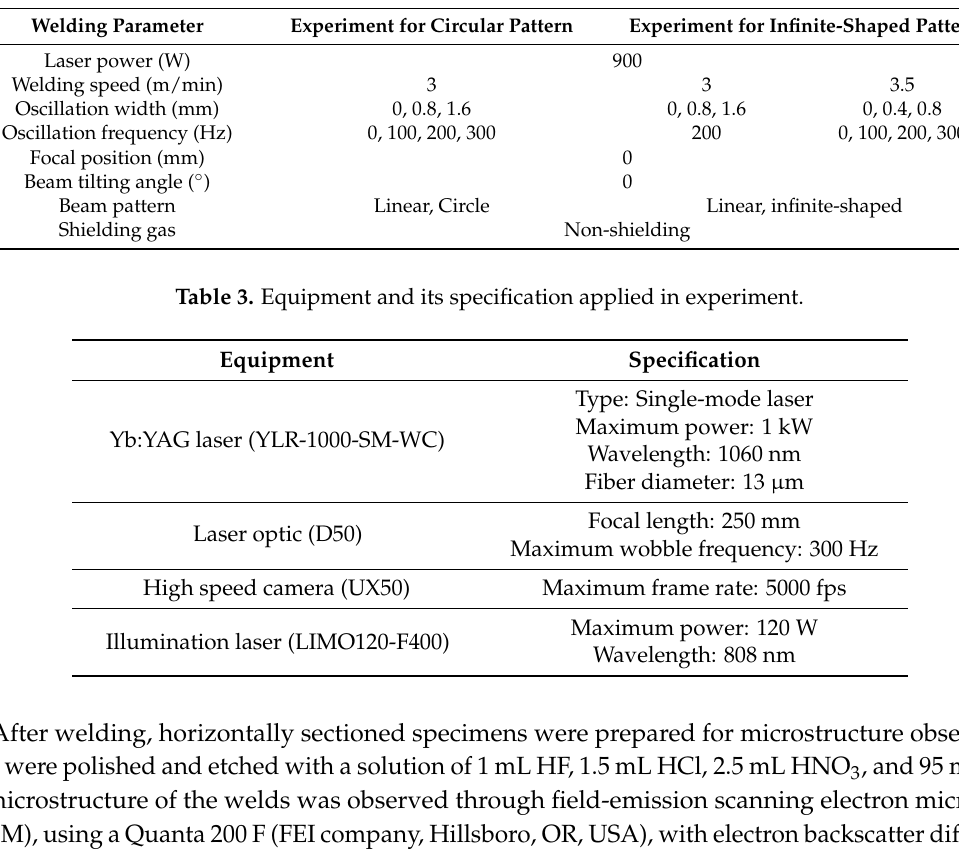
Table 2. Laser welding conditions for the experiment.